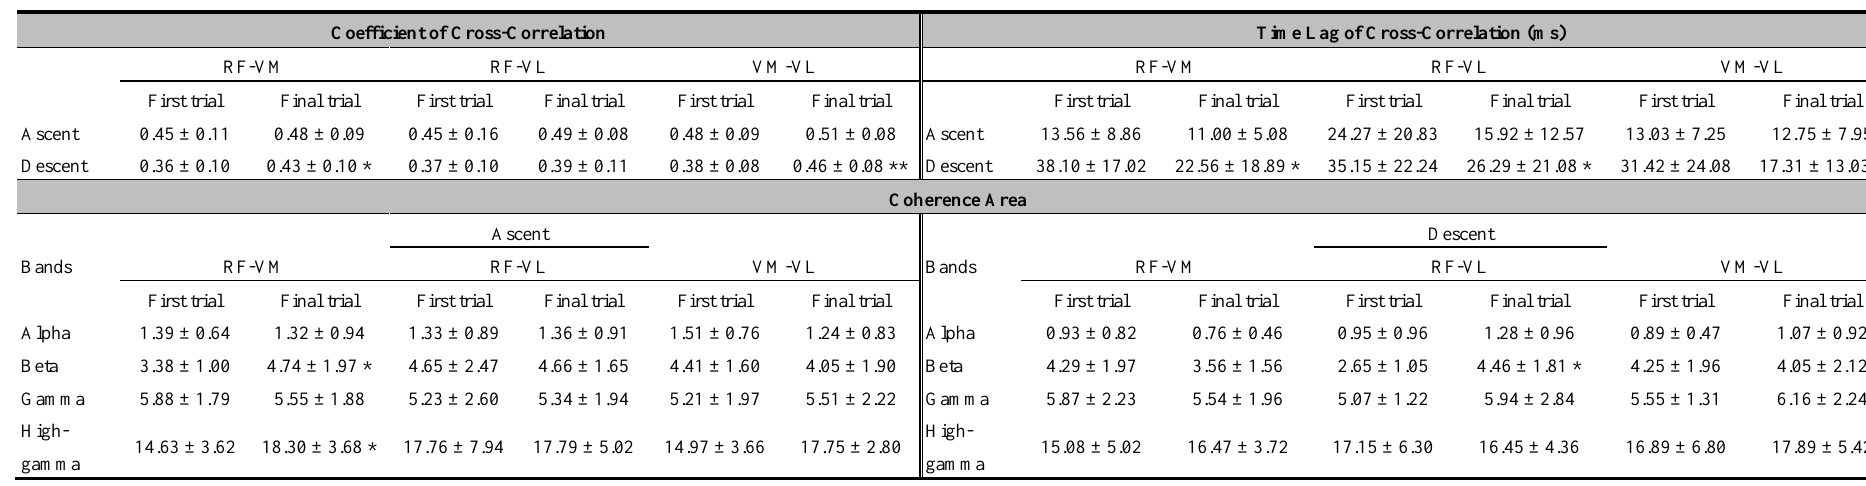
Table 2. Comparison of the changes in the coefficient and time lag of cross-correlation, and coherence area in different frequency bands (alpha band: 8–12 Hz; beta band: 15–30 Hz; gamma band: 30–60 Hz; high-gamma band: 60–120 Hz) among three muscle pairs of RF-VM, RF-VL and VM-VL between the first and final trial of the exhausting stepping exercise. Asterisks showed the significant difference between the first and final trial ( * p < 0.05 ; ** p < 0.01 ).